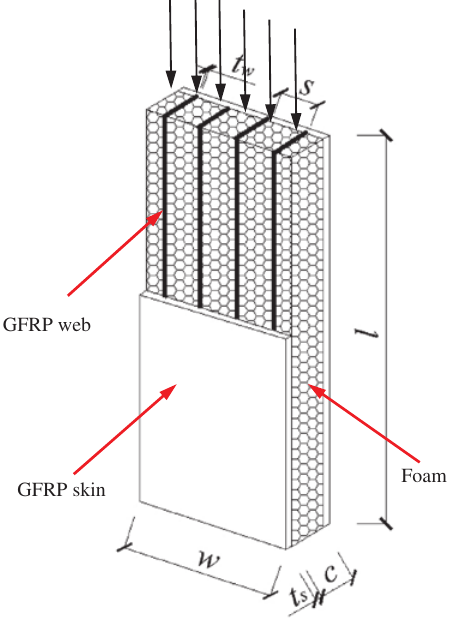
Figure 1: Sandwich wall panel with GFRP skin and a foam-web